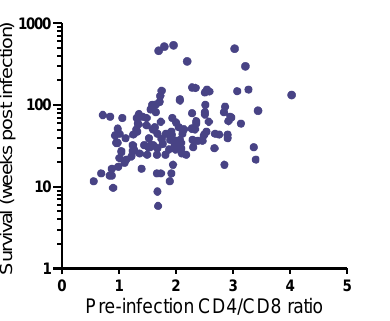
Figure 3. Correlation of pre-infection CD4 / CD8 ratios with sur- vival time. CD4 + and CD8 + lymphocyte populations were deter- mined by flow cytometric analysis as percentages of CD3 + cells. Their ratios correlate with survival time after SIV infection ( n = 115, p < 0 . 0001, rs = 0.39, Spearman rank correlation). Each pre- infection value corresponds to the mean of two to three independent